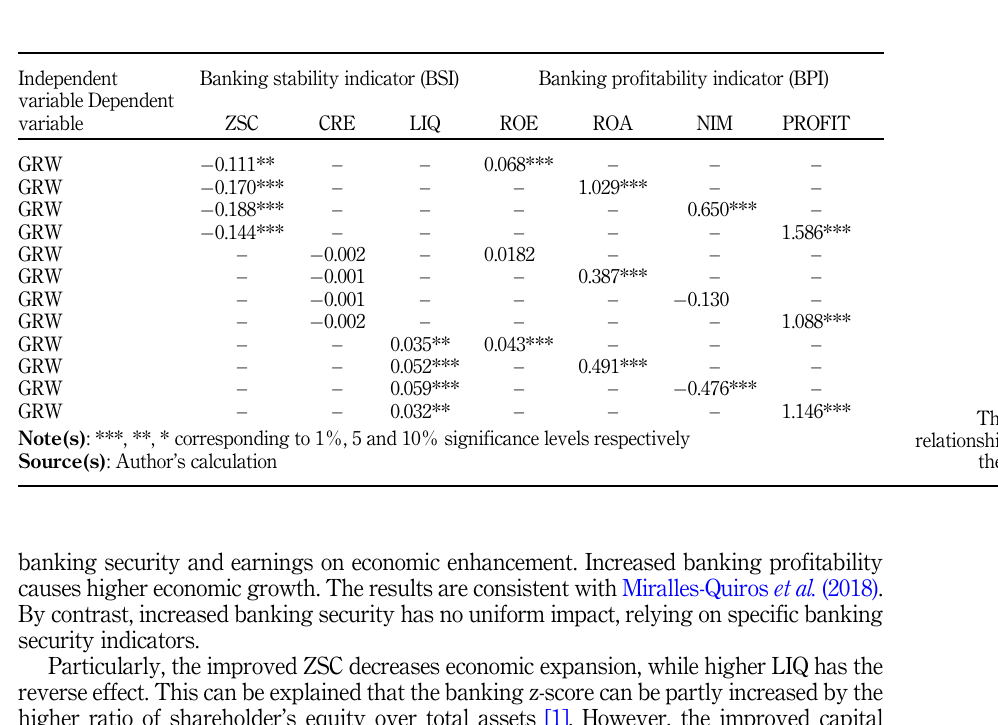
Table 4. Summary of the